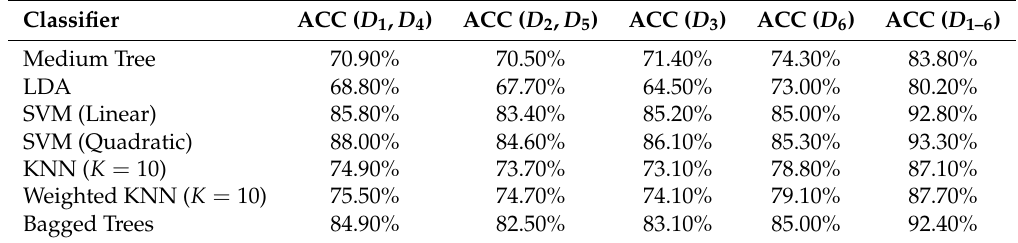
Table 6. Comparison of the contribution of different frame descriptors, the features used are both basic and wavelet ( J = 10) features.